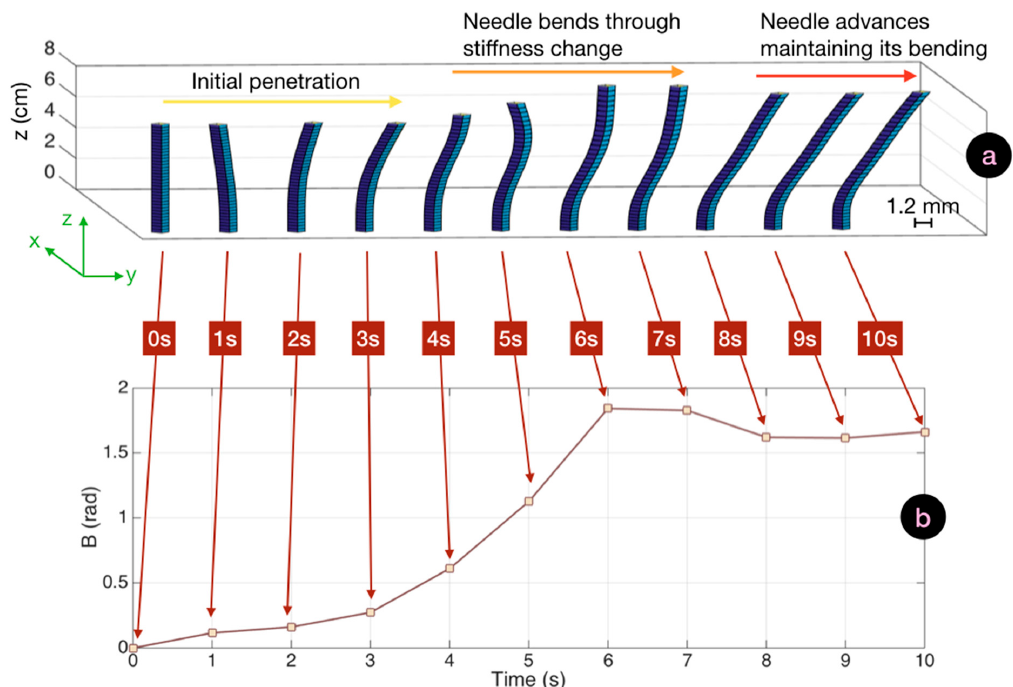
Figure 7. Bending cinematic of an insertion with large curvature and the corresponding SBPA chart. ( a ) Cinematic of a straight insertion (10 s duration) displaying the reconstructed silhouette of the needle (1.2 mm cross-section on xy , 8 cm length along z ) through the whole insertion. ( b ) Corresponding SBPA chart showing the value of B corresponding to each bending pattern.